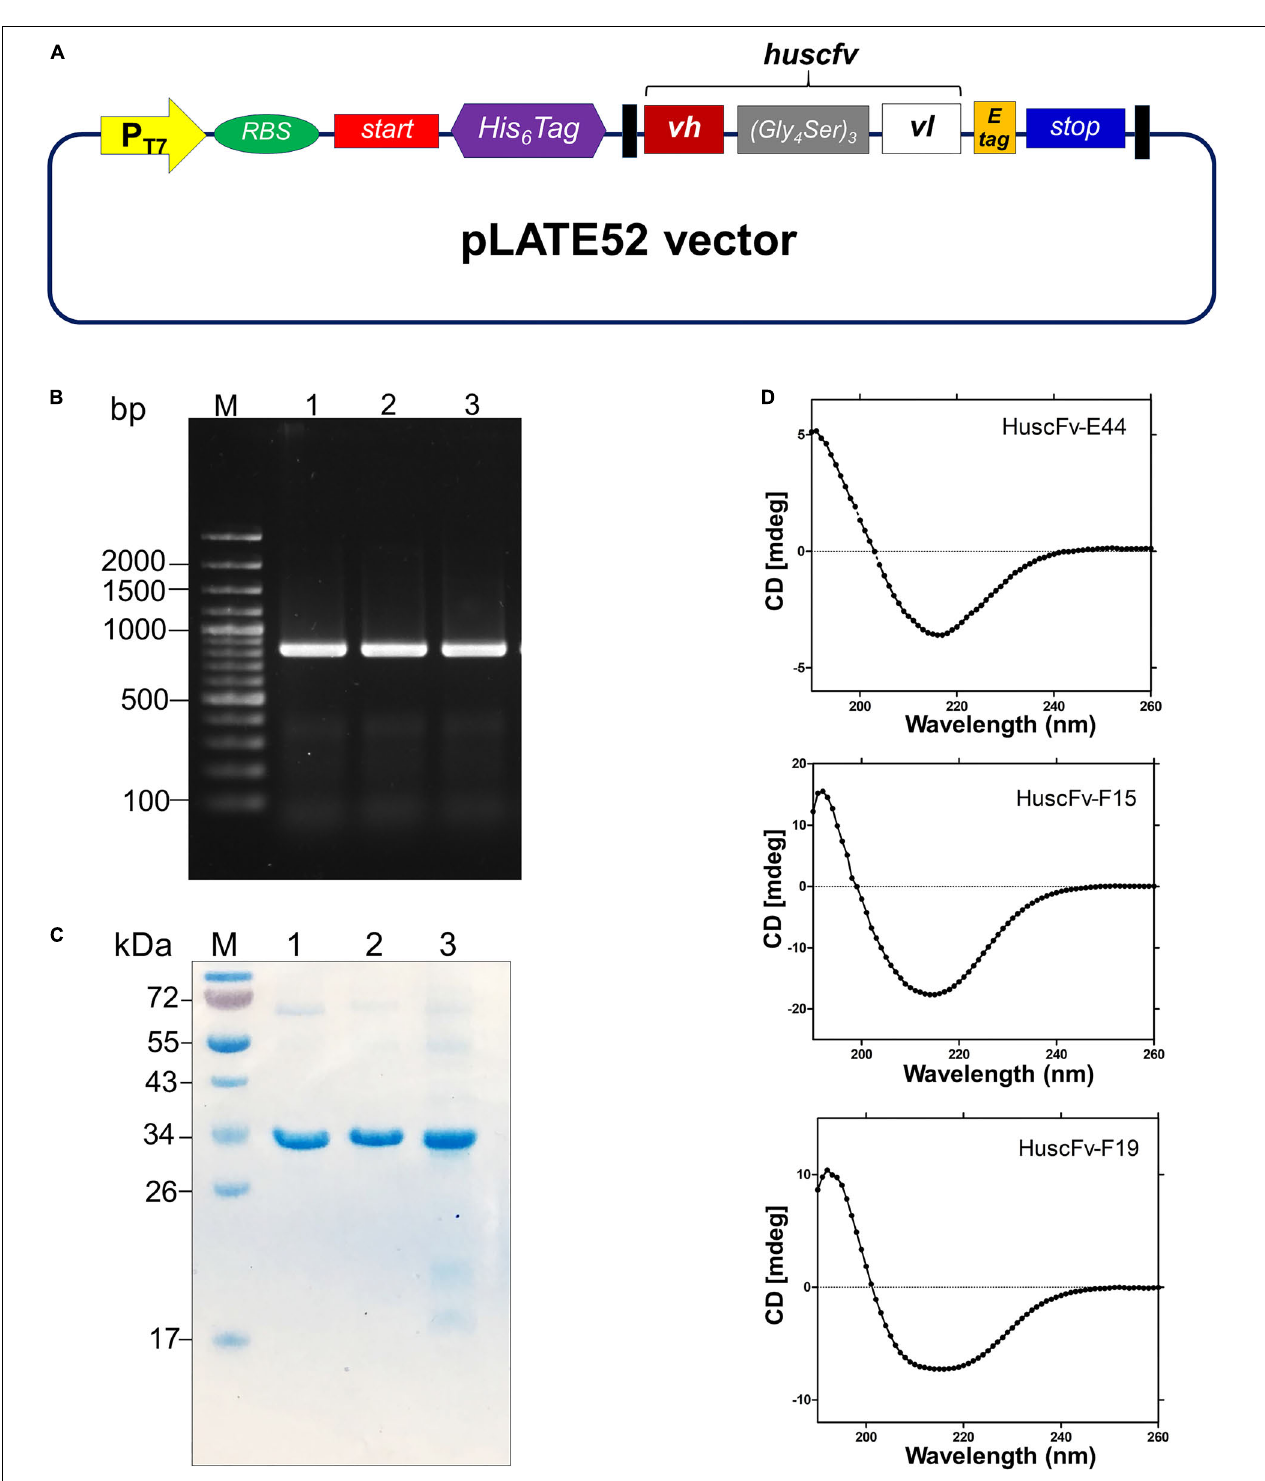
FIGURE 3 | Production and characterization of HuscFvs to 3O-C12-HSL. (A) Schematic diagram of the inserted DNA construct in pLATE52 where the DNA sequence coding for HuscFv ( vh-linker-vl ) was flanked with DNA sequences of 6 × His at the 5 (cid:48) end and E-tag at the 3 (cid:48) end. (B) Amplicons of huscfv -LIC fragments ( ∼ 850 bp) for sub-cloning into pLATE52 vector. M, 100 bp-plus DNA ladder; 1–3, huscfv -LIC amplicons of three representatives transformed NiCo21(DE3) E. coli clones. Numbers at the left are DNA sizes in bp. (C) Stained SDS-PAGE-separated purified recombinant HuscFvs. M, protein standard; 1–3, purified HuscFv-E44, HuscFv-F15 and HuscFv-F19, respectively. Numbers at the left are protein masses in kDa. (D) CD spectra of the refolded HuscFv-E44, HuscFv-F15, and HuscFv-F19.